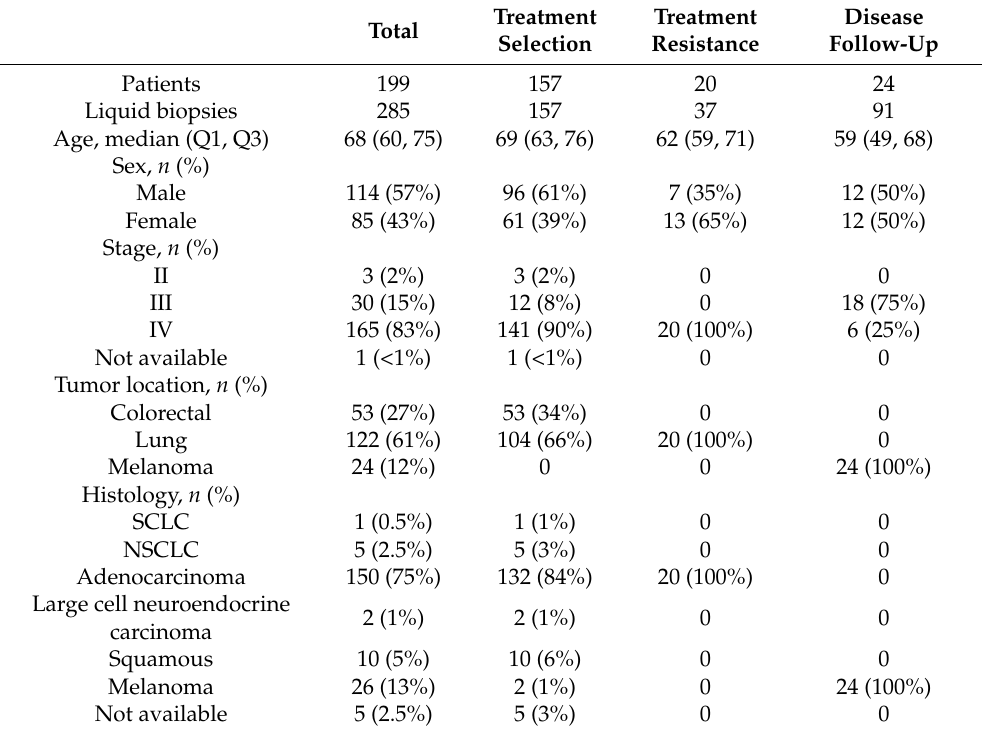
Treatment Treatment Disease Total Selection Resistance Follow-Up